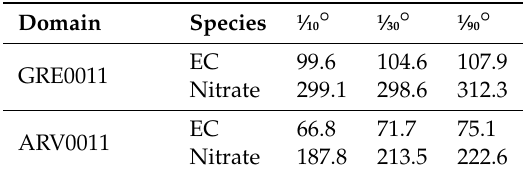
Table 8. Impact of the resolution on the integrated mass of Elemental Carbon and Nitrate (in ton.day) on average for the period 15 November to 20 December for the two target domains GRE0011 and ARV0011.